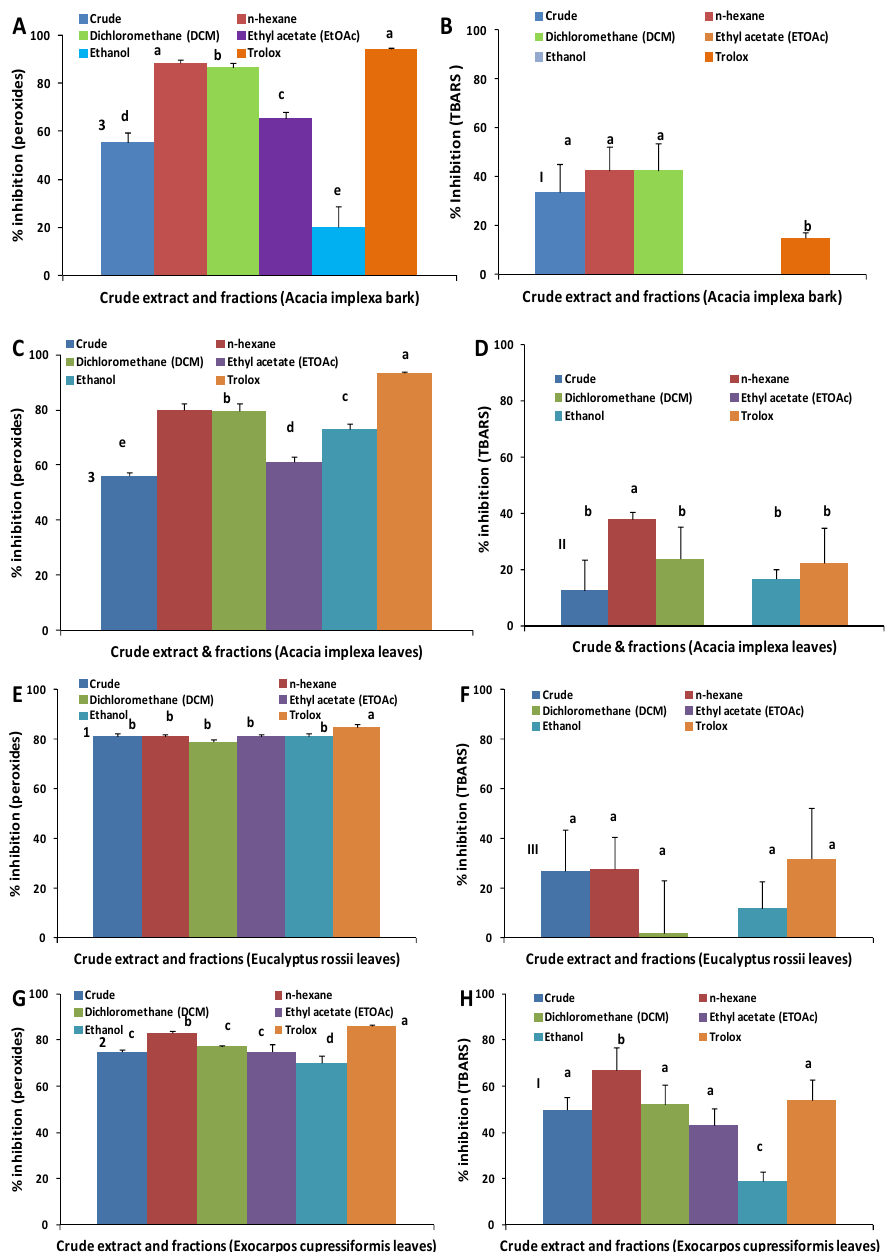
Figure 2. Antioxidant activity (% inhibition) for the FTC (peroxides) assay: ( A ) A. implexa bark, ( C ) A . implexa leaves, ( E ) E. rossii leaves and ( G ) E. cupressiformis leaves; and for the TBARS assay: ( B ) A. implexa bark, ( D ) A. implexa leaves, ( F ) E. rossii leaves and ( H ) E. cupressiformis leaves. Different letters (a–e) in crude extract and fractions of same species show significant difference; different numbers (1–3) for FTC and different capital Roman numerals (I–III) in crude extracts of the different species show significant difference at p < 0.05. Results are presented as mean ± standard deviation (n = 3), and statistically significant difference was determined by one-way ANOVA and Tukey’s HSD post hoc test.